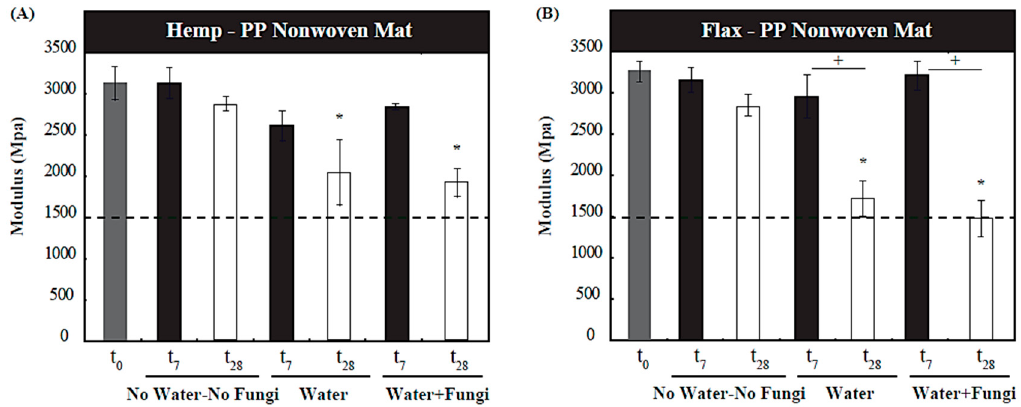
Figure 2. Young’s modulus of ( A ) hemp and ( B ) flax NFRC samples at 0, 7 and 28 days. Samples in columns with a “ * ” were significantly different from the baseline (control at t 0 ) with a p -value < 0.05. The dashed line represents typical modulus of elasticity for the same grade polypropylene used in the NFRC specimens (approximately 1500 MPa). The “ + ” signs indicate significance within the sample groups (i.e., the effect of exposure time).